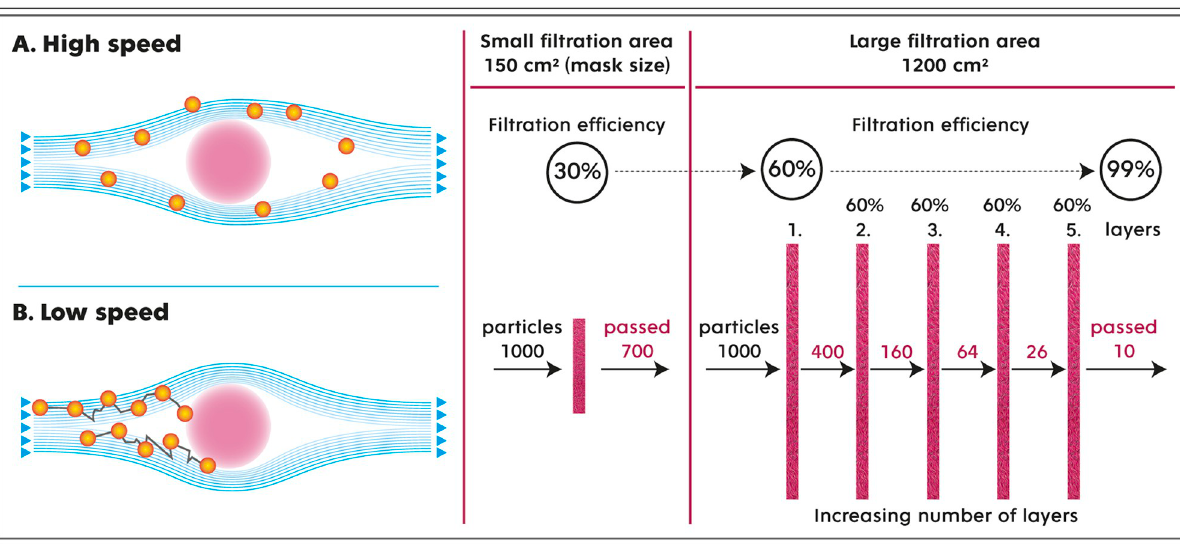
Fig 1. Principle of filtration efficiency enhancement. Panel A shows how the trajectory of the particle motion changes if we reduce the speed of the air that carries it around the filter fiber (cross-section). At low speeds (face velocities), as a result of Brownian motion, the particle deviates more from its original streamline, and the probability of it being trapped on the fiber surface increases (typically for particles smaller than 1 micron). Reducing the flow rate and thus increasing the filtration efficiency can be achieved by increasing the filter area, as shown in the example in Panel B. Increasing the number of filter layers leads to an exponential decrease in the number of particles passing through the filter and an increase in the filtration efficiency to 99%.